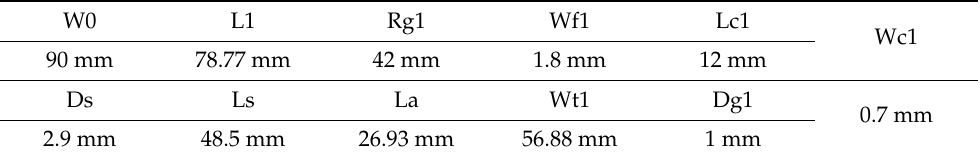
Table 4. Physical parameters of proposed slot antenna